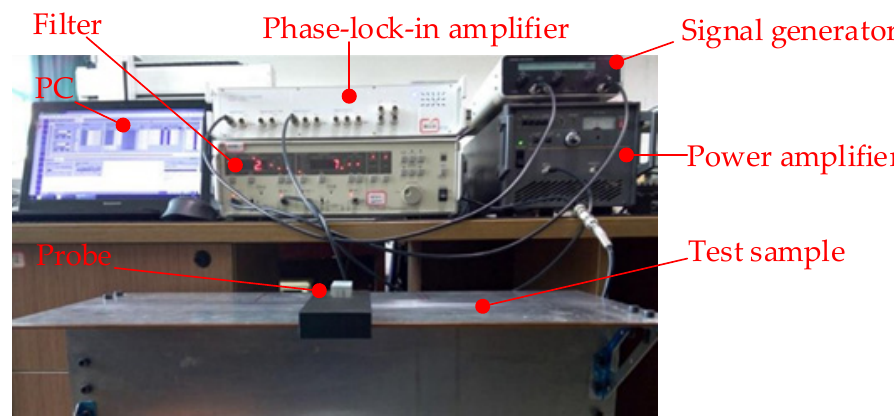
Figure 18. Block diagram of remote field eddy current testing system for aircraft long truss structure.